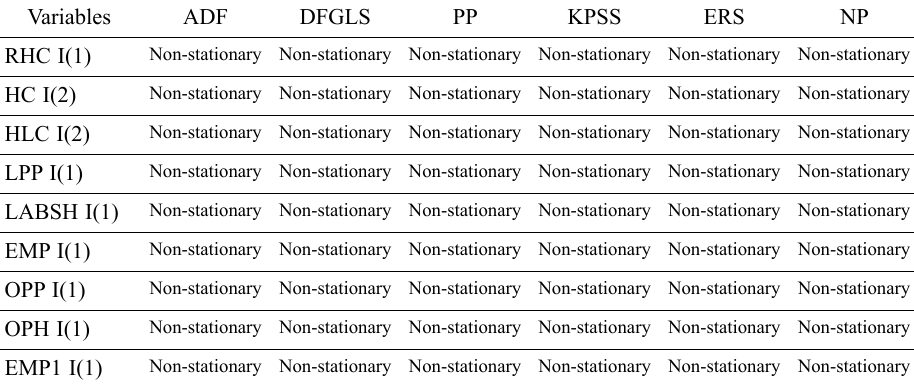
Table 2. Summary results of the battery unit root